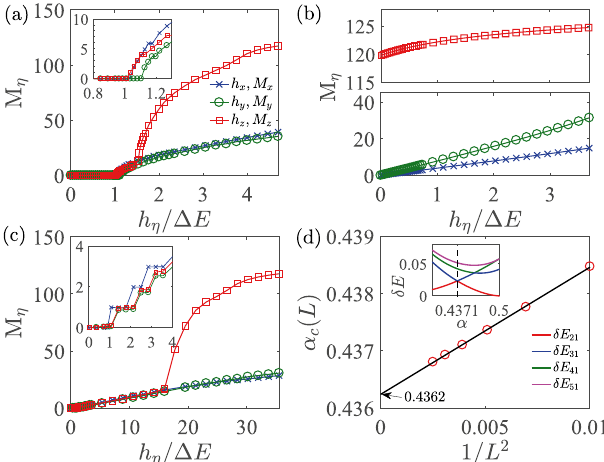
1 π 0.2 . The three critical Zeeman α Figure 6. Magnetizaton M η at θ 7 . ( a ) Exact dimer phase with 2 , z = − = = 1 0.0425 . ( b ) z -FM phase with α 0.047 and h c 0.044 , h c 0.043 , and excitation gap δ E fields are h c x 2 , y = z = = = = 0.054 . ( c ) Dimer phase with α 0.45 , z 0.006 and h c 0.4 , δ E 0.2 , h c 0.005 , h c 0.006 , z y = x = z = = = = − = − 0.0056 . These results are obtained with L 256 based on DMRG method. ( d ) Critical boundary for dimer δ E = = π 0.4362 is obtained by extrapolating to infinity length (see 0.2 . The critical point α phase at θ c = 7 and z = − = Eq. 35). Inset shows the boundary determined by level crossing between the first and second excited states 67